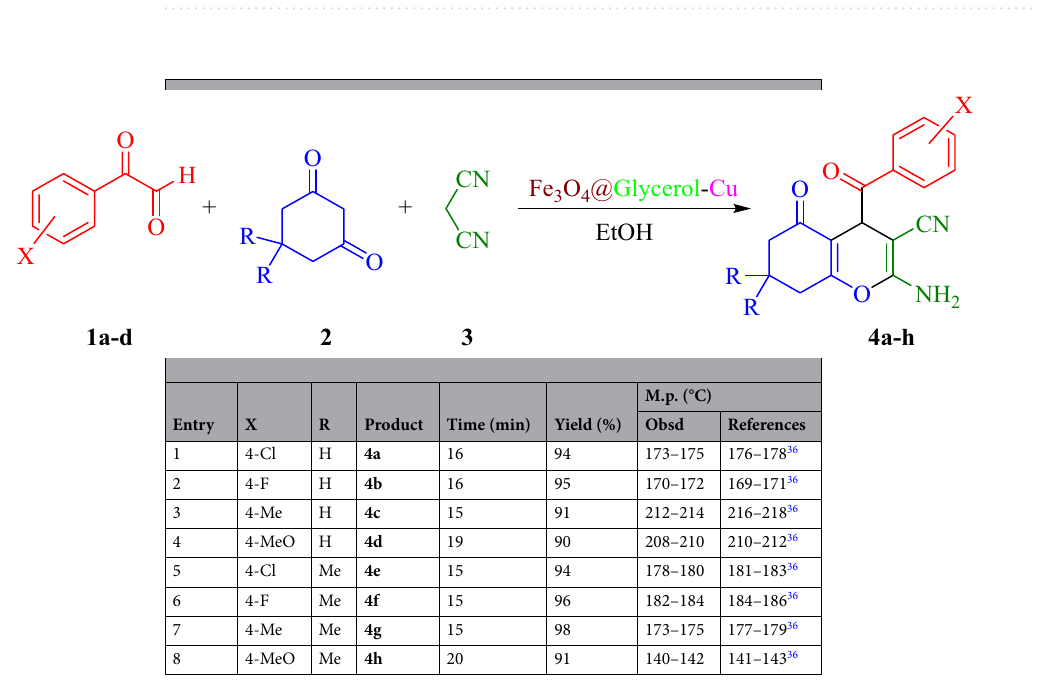
Table 1. Effects of various parameters on the synthesis of 4b . Reaction conditions: Arylglyoxals (1 mmol), malononitrile (1.1 mmol), and cyclic 1,3-dicarbonyl compounds (1 mmol) with various solvents. Significant values are in bold.